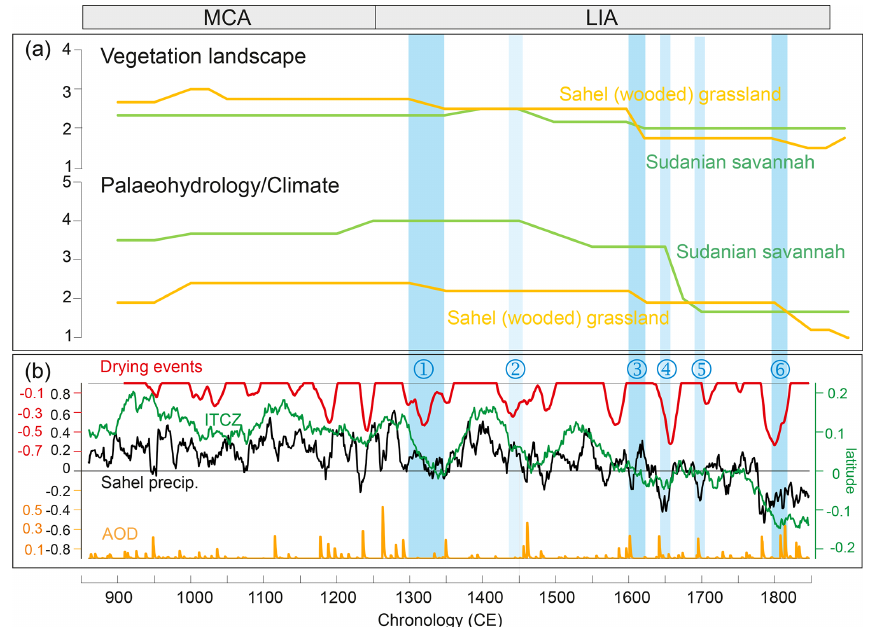
Figure 7. Multiproxy records of hydrology and vegetation during the last millennium in the driest biomes (Sahel and savannah zone) in western Africa (a) and long-term evolution of rainfall over the Sahel as simulated by the IPSL-CM6A-LR past1000 model (b) . Panel (b) : 10-year filtered ensemble-mean Sahel precipitation index (mmd − 1 ) (black line); 50-year filtered anomalous latitudinal position of the JAS ITCZ (defined as the latitudinal maximum zonal-mean rainfall in 40 ◦ W–10 ◦ E) in the past1000 simulations to the piControl JAS mean position (in degrees of latitude) (green line); global-mean AOD (volcanic forcing) (orange line); Sahel Drying Persistence Index defined as the 50-year running negative trend values over the Sahel ensemble-mean JAS precipitation index (mmd − 1 per 50 years) (red line). Blue bars and numbers highlight the main climate and environmental degradation thresholds identified in the